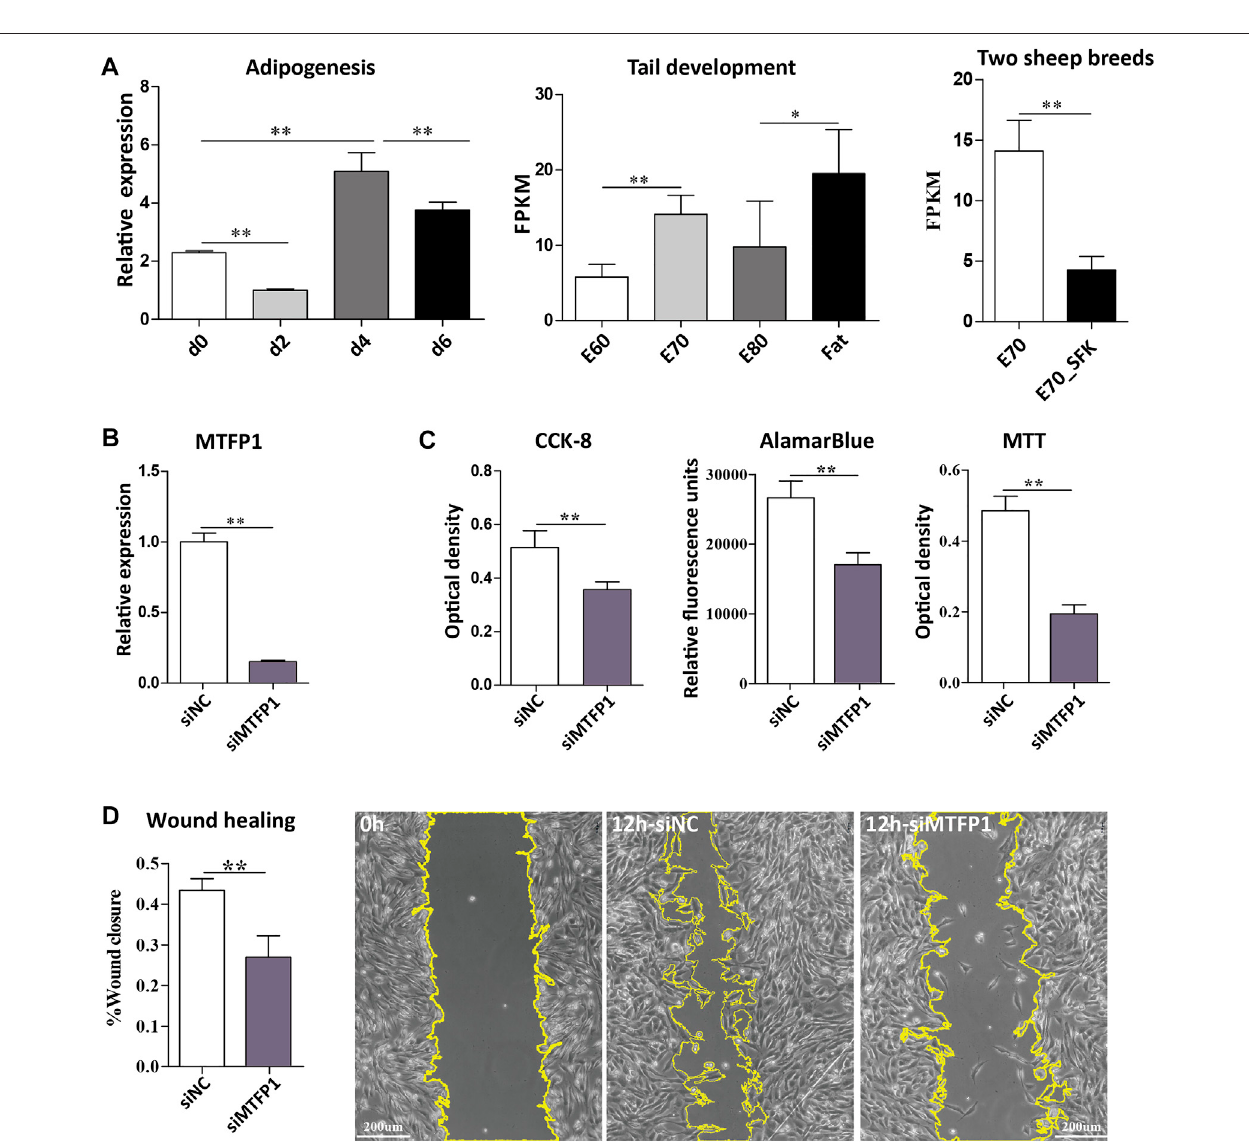
FIGURE 4 | Expression of the MTFP1 gene and the effect of siRNA-induced knockdown of MTFP1 on cell proliferation and migration. (A) Relative expression of MTFP1 at d0, d2, d4 and d6 of adipocyte differentiation and absolute expression of MTFP1 in tail tissues at different developmental stages. (B) Silencing ef fi ciency of siMTFP1 . (C) Thein fl uenceof siMTFP1 on cellproliferationdetected usingCCK-8,MTT, and alamarBluemethods. (D) The effect ofsiRNA-induced MTFP1 knockdown on wound healing as measured by wound closure rate. The micrographs with yellow highlighting represent the wound area of cells treated with siMTFP1 and siNC at 0 and 12 h. Error bars represent mean ± SD. * p < 0.05, ** p < 0.01.